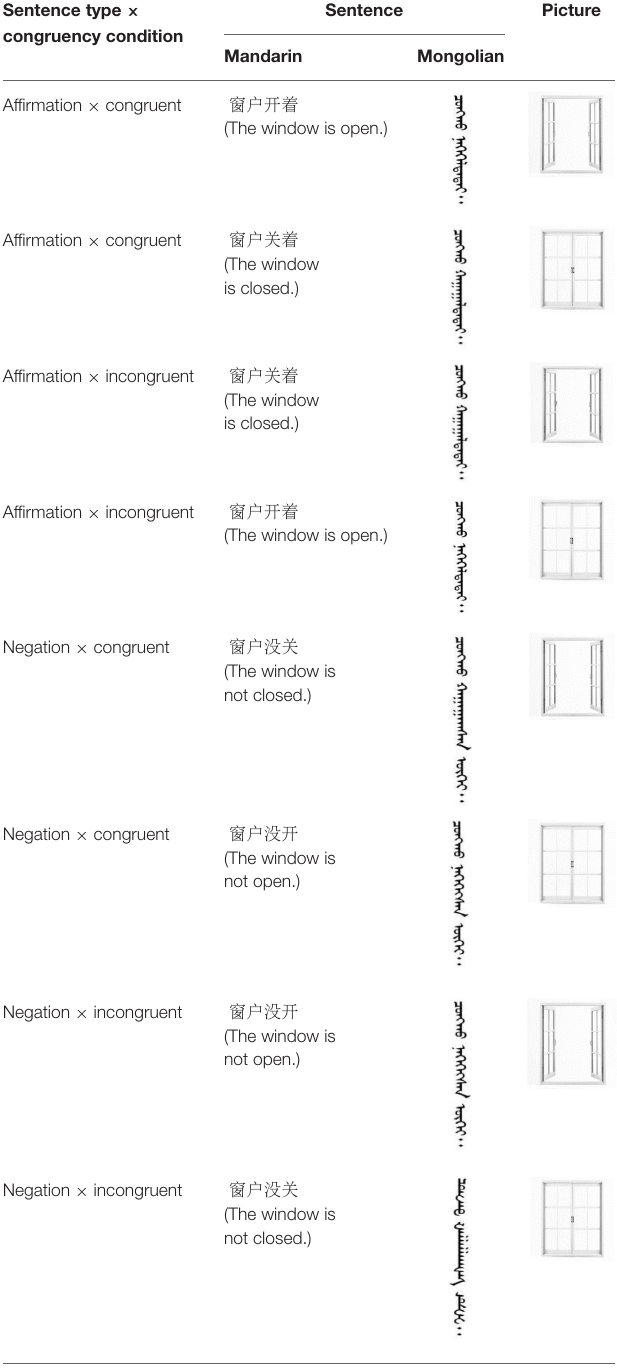
TABLE 1 | An example of one object’s eight versions in experimental